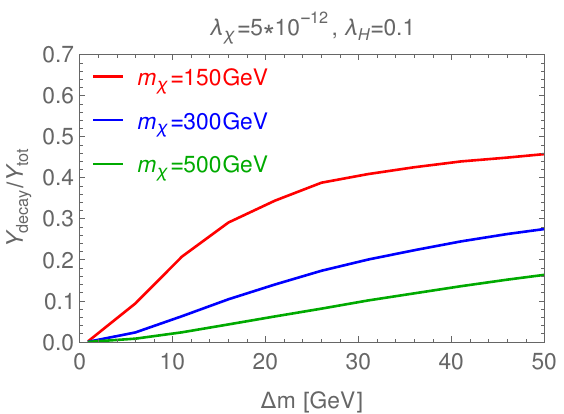
Figure 4 . The ratio of the freeze-in yields Y (cid:12) =Y (cid:12) as a function of (cid:1) m when taking only decay tot decay processes into account for Y (cid:12) and including all the relevant scattering and decay processes for decay Y (cid:12) . We show the results for three di(cid:11)erent values of the DM mass m (cid:31) 2 f 150 ; 300 ; 500 g GeV while tot keeping (cid:21) (cid:31) = 5 (cid:1) 10 (cid:0) 12 and (cid:21) H = 0 : 1